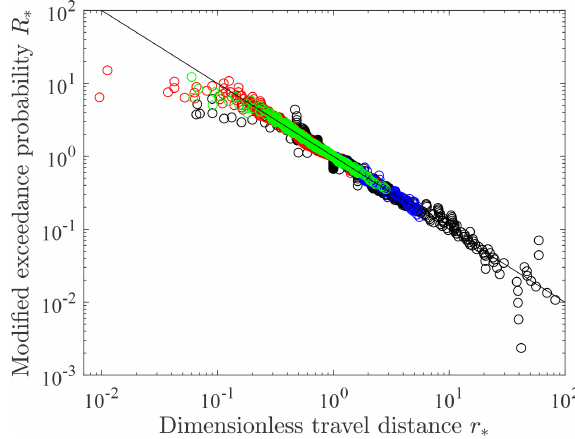
Figure 2. Plot of modified exceedance probability R ∗ versus di- mensionless travel distance r ∗ and line with log–log slope of − 1 for laboratory experiments described by Gabet and Mendoza (2012) (green) and Furbish et al. (2021b) (red) and field-based experiments described by DiBiase et al. (2017) (blue) and Roth et al. (2020) (black). Data for A < 0 fall to the left of r ∗ = 10 0 = 1 with values in the tails represented by smaller values of r ∗ . Data for A > 0 fall to the right of r ∗ = 10 0 = 1 with values in the tails represented by larger values of r ∗ . Total data number is N = 5671. Figure repro- duced from Furbish et al.